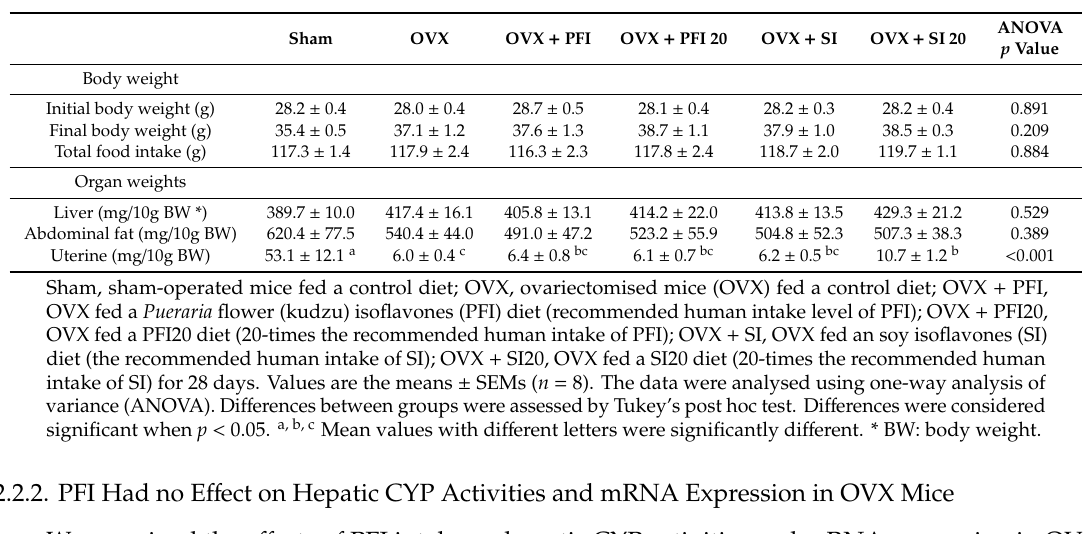
Figure 1. Hepatic mRNA expressions of ( A ) CYP1A2, ( B ) CYP2C29, ( C ) CYP3A11 and ( D ) CYP 3A41 in normal female mice in Experiment 1. Control, mice fed a control diet; PFI, mice fed a Pueraria flower (kudzu) isoflavones (PFI) diet (the recommended human intake of PFI); PFI20, mice fed a PFI20 diet (20-times the recommended human intake of PFI); PFI50, mice fed PFI50 diet (50-times the recommended human intake of PFI) for 14 days. Values are the means ± SEMs ( n = 8). The data were analysed using one-way analysis of variance (ANOVA). Differences between groups were assessed by Tukey’s post hoc test. Differences were considered significant when p < 0.05. a, b, c Mean values with different letters were significantly different. Table 2. Body weight, food intake, and wet weight of liver, abdominal fat, and uterine in mice in Experiment